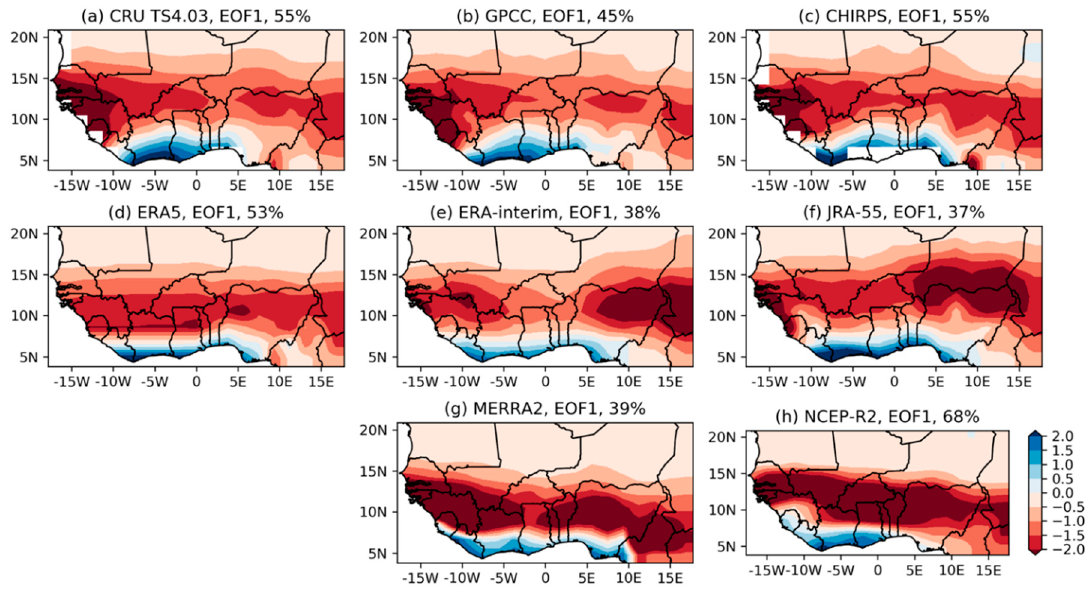
Figure 6. Leading empirical orthogonal function (EOF1) patterns of the mean JJAS precipitation from the 1981–2016 period for CRU, GPCC, CHIRPS, and the reanalysis datasets. The variance explained by each EOF for each dataset is shown at the top-right-hand side of each panel member.